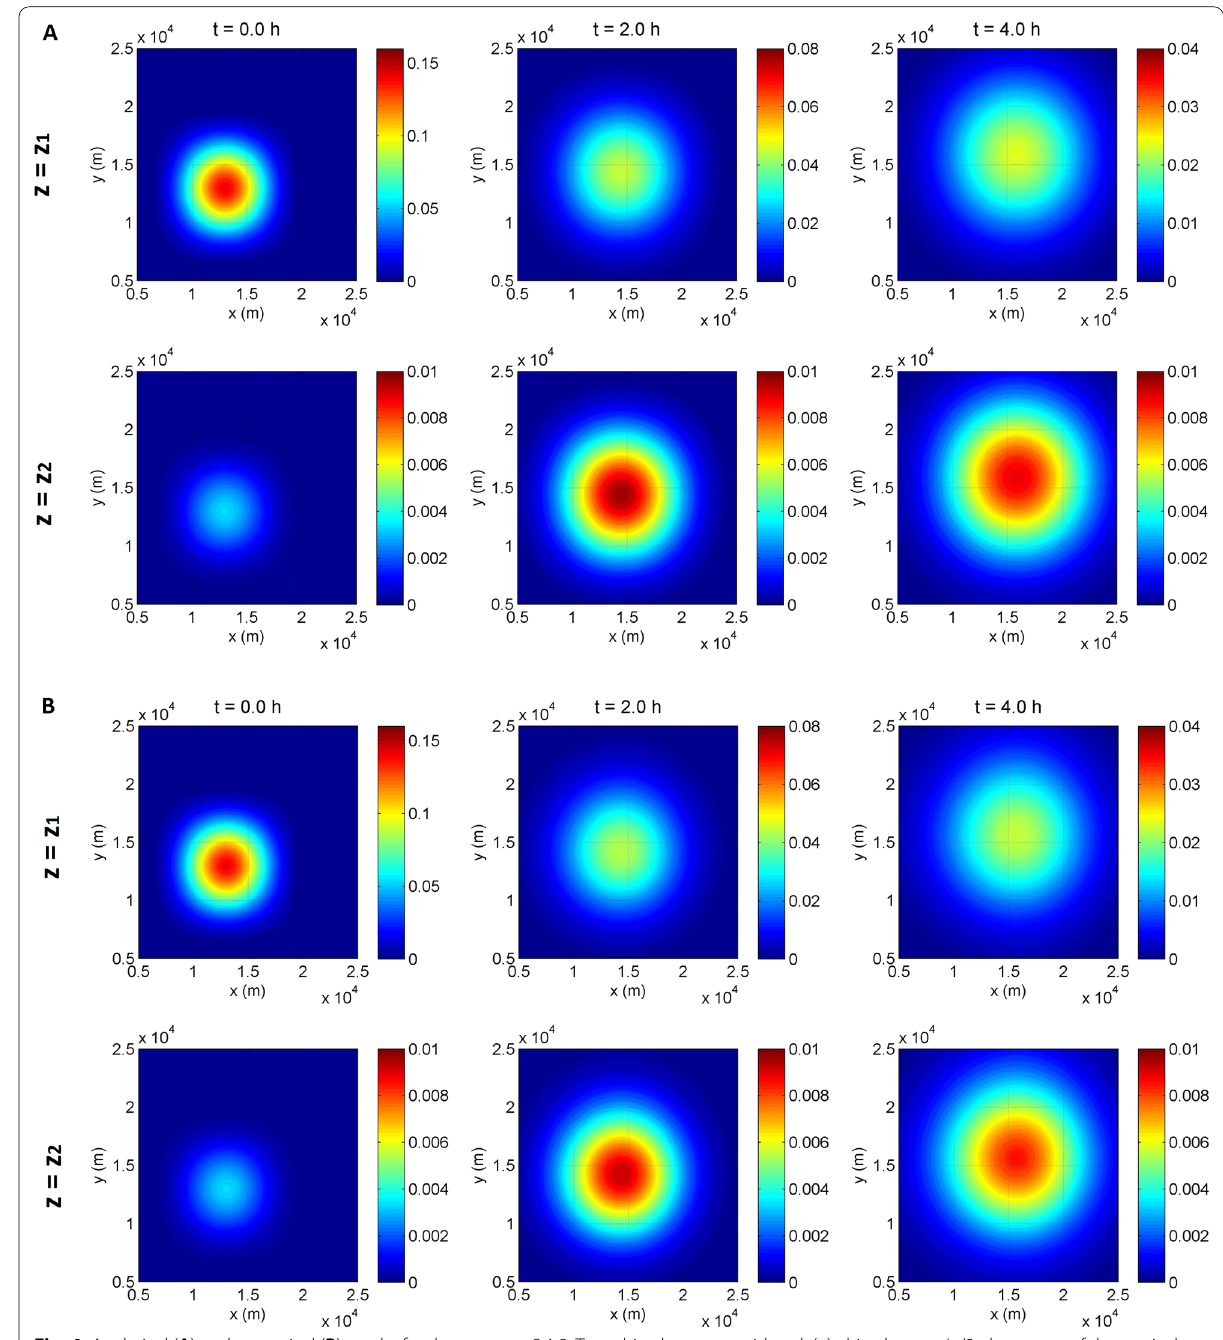
Fig. 4 Analytical ( A ) and numerical ( B ) results for the test case 3.1.3. Two altitudes are considered: ( a ) altitude z 1 , at L z /2, the center of the vertical domain ( z 1 50 m) and ( b ) altitude z 2 , at L z /4 of the vertical domain ( z 2 = Note that the time domain shown in this figure corresponds with the numerical simulation, i.e., the instantaneous point source is injected at t t o (see = −